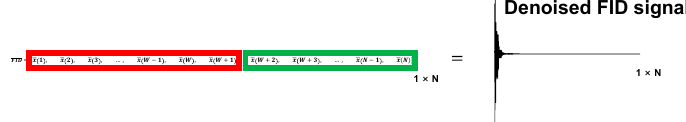
Figure 1. Schematic representation of the low-rank denoising approach. ( A ) Conversion of the FID patch signal to a Hankel matrix, H. ( B ) Truncated SVD of the Hankel matrix, H. ( C ) Reconstruction of the noise-reduced FID using the denoised Hankel matrix, 𝐻(cid:3365) . SVD, singular value decomposition; N, number of data points; r, rank or number of basis spectra; W = N/2; H, Hankel matrix; FID: free induction decay signal; 𝐻(cid:3365) , denoised Hankel matrix; 𝐹𝐼𝐷(cid:3364)(cid:3364)(cid:3364)(cid:3364)(cid:3364) , denoised FID signal.